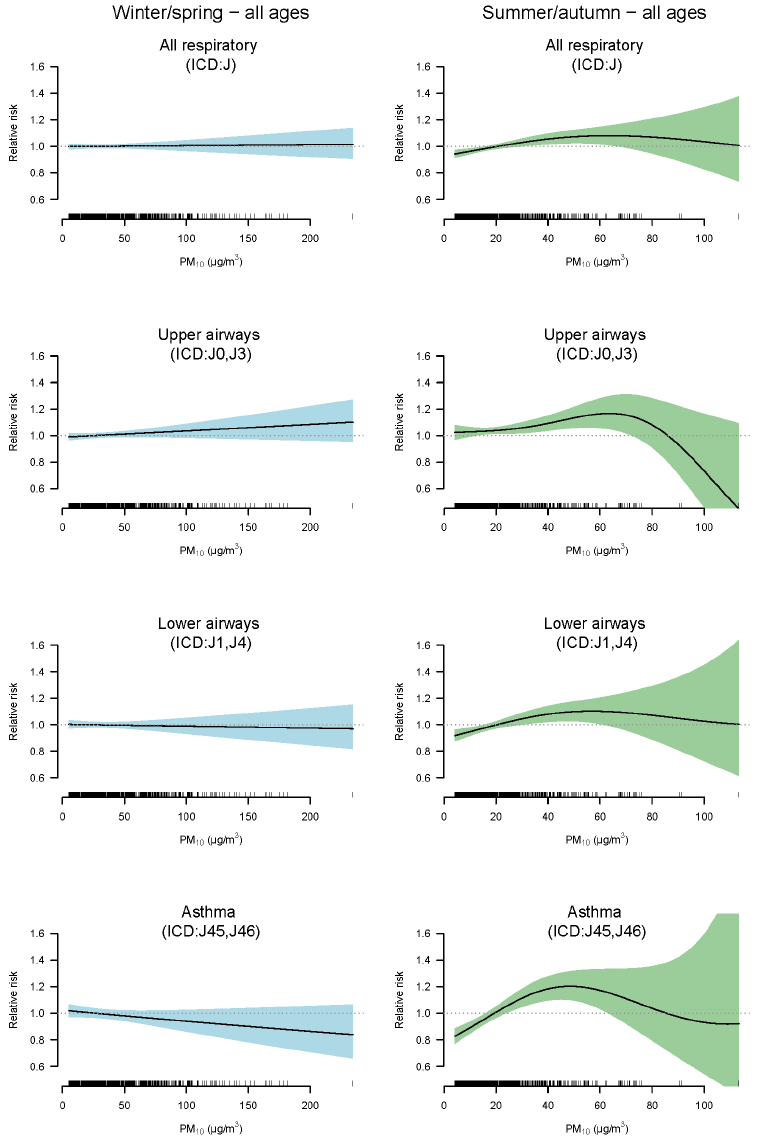
Figure 3. The relative increase (RR with 95% CI) in respiratory visits (all ages) in Visby with concentrations in PM 10 (lag 01) estimated with regression models allowing for non-linear associations. These analyses are divided into “all respiratory diseases”, “upper airways”, “lower airways”, and “asthma” during winter/spring (January–April) and summer/autumn (May–December).